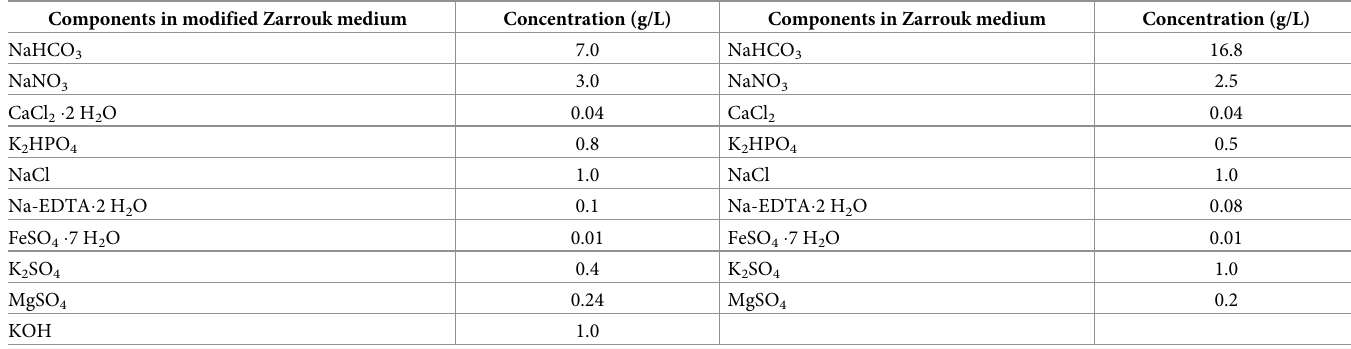
Table 1. Chemical composition of Zarrouk Medium and modified Zarrouk Medium.